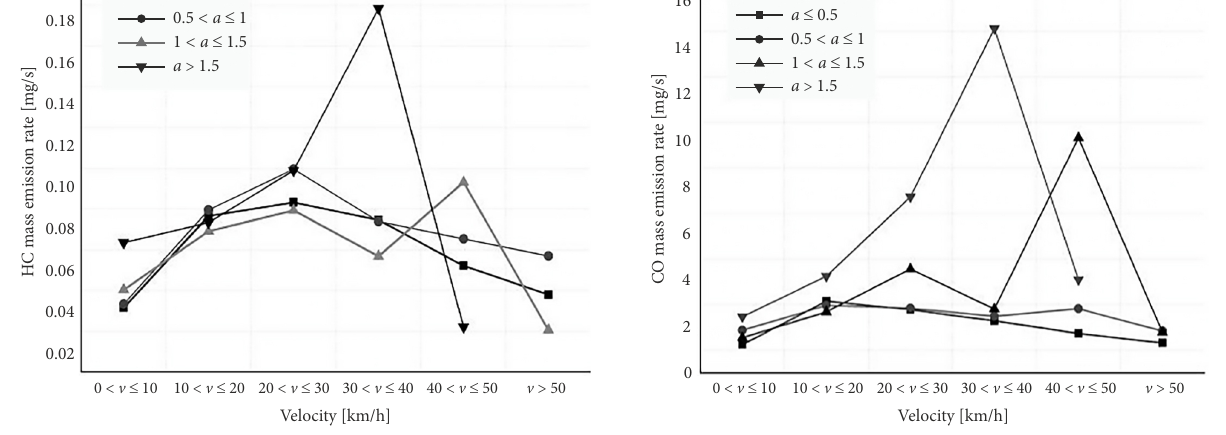
Figure 6. Effect of both velocity and acceleration on the mass emission rate of HC